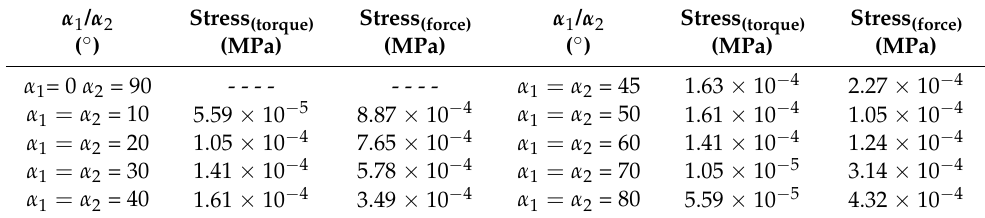
Table 7. Absolute value of the maximum equivalent stress